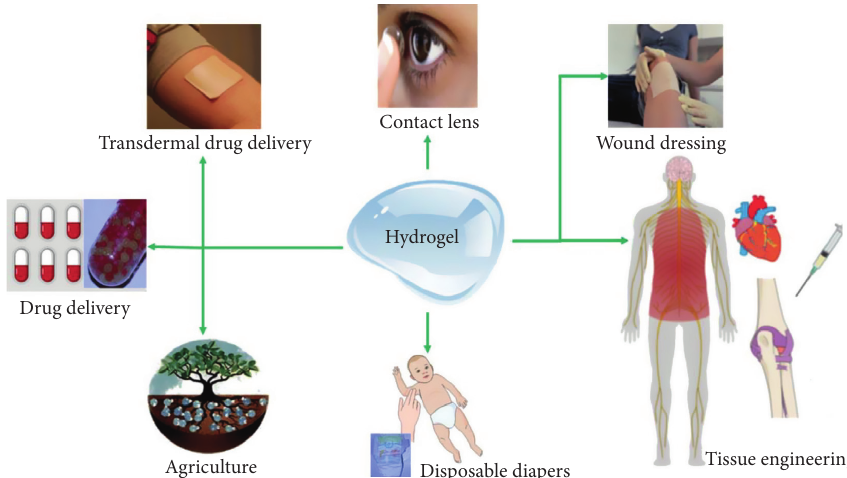
Figure 9: Application of hydrogels in various